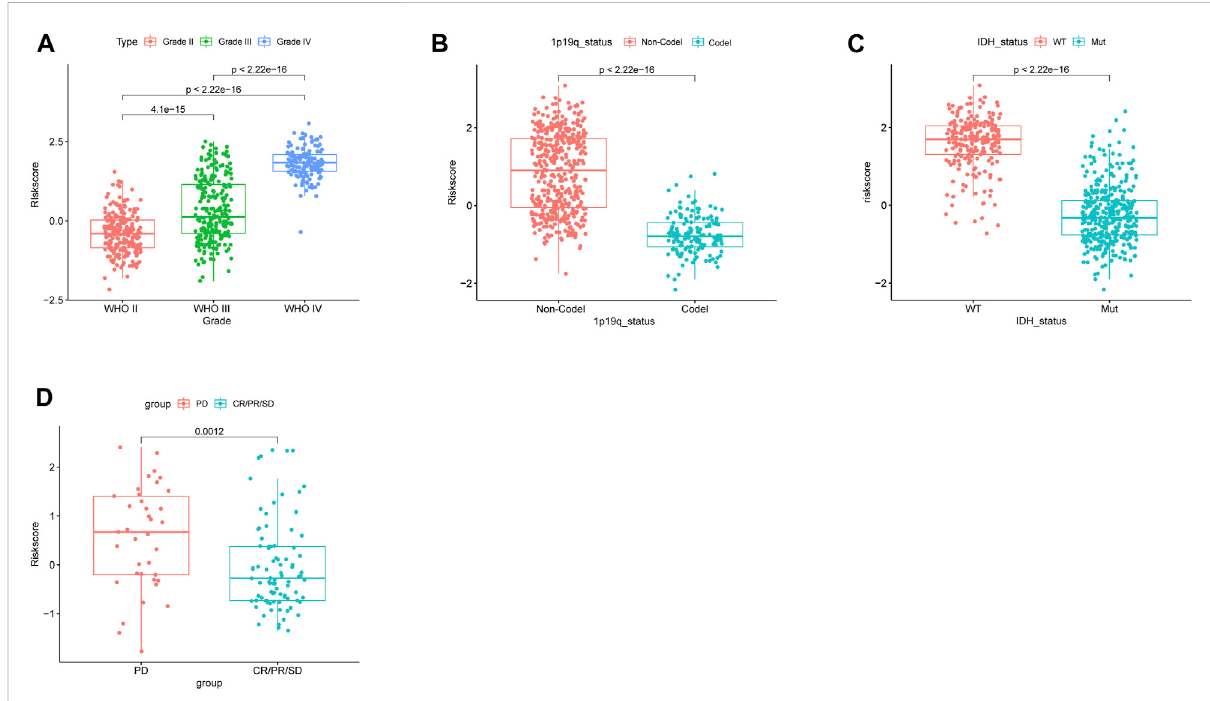
FIGURE 4 Correlation between the risk score and clinicopathological features in the TCGA database. (A) Correlation between the risk score and WHO classi fi cation. (B) Correlation betweenthe risk score and 1p/19qcodeletion status. (C) Correlation between the risk score and IDH mutant status.